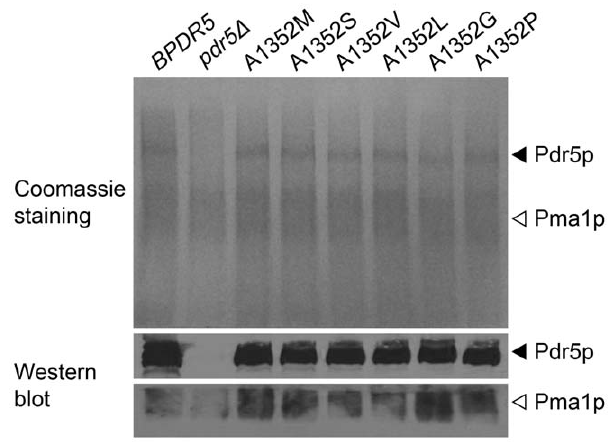
Figure 5. Membrane localization of Pdr5p and its mutant variants. Isolated plasma membranes (15 m g/lane) were electropho- resed on an SDS–8% polyacrylamide gel and visualized with Coomassie blue (top panel). Pdr5p (middle panel) and Pma1p (bottom panel) were immunodetected with specific antibodies as described in the materials and methods section. Filled arrowheads indicate Pdr5p and open arrowheads indicate Pma1p. Coomassie blue stained SDS-PAGE gel (upper panel) and western blot (lower panel) of the same strains are shown.